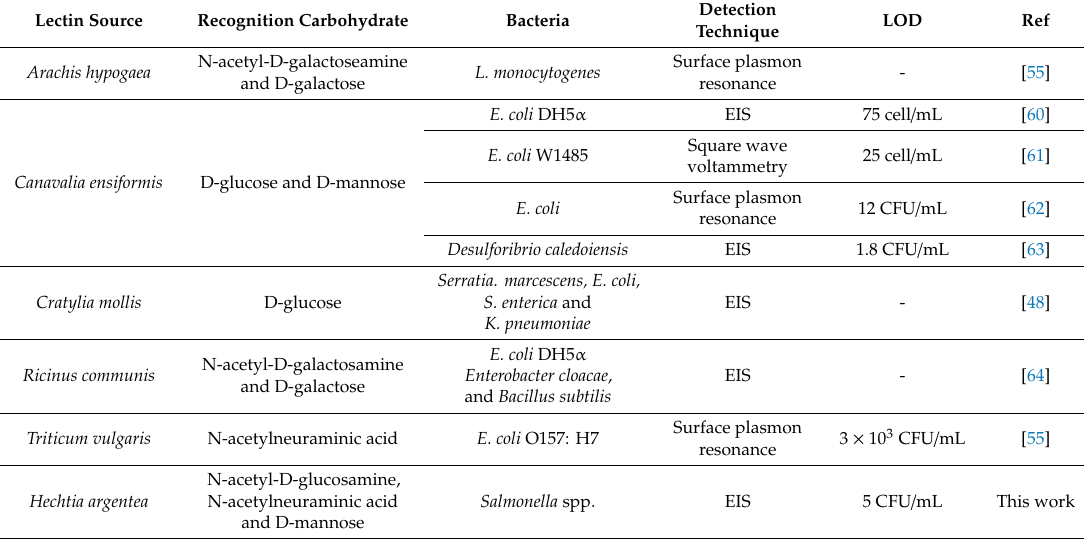
Figure 7. Nyquist plots of Salmonella spp. in the concentration range of: ( a ) 0, ( b ) 10 3 , ( c ) 10 4 , ( d ) 10 5 , ( e ) 10 6 and ( f ) 10 7 CFU mL − 1 . Table 1. Lectin-based biosensors for bacteria